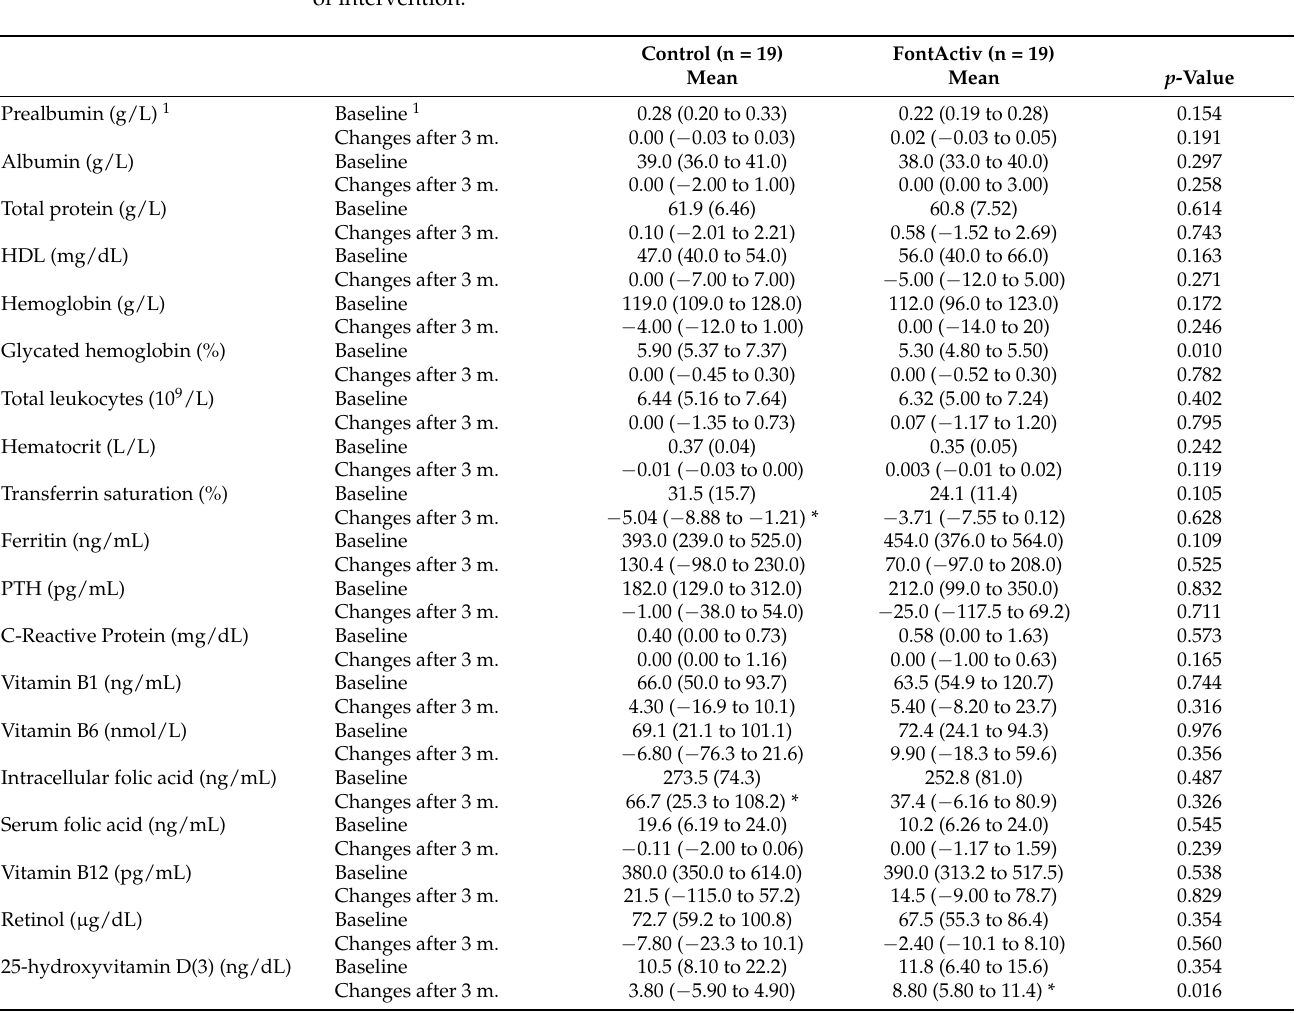
Table 4. Biochemical changes in CKD participants according to the intervention arm after 3 months of